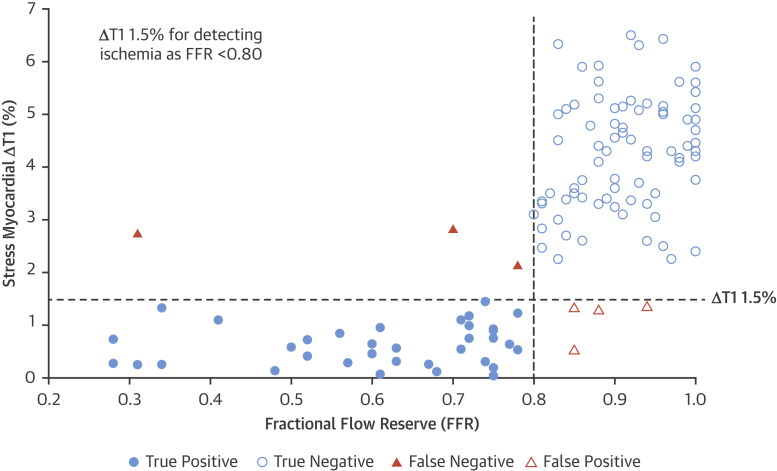
Relationship Between CMR Stress Myocardial ΔT1 and Invasive FFRA ΔT1 threshold of 1.5% optimally distinguished myocardial territories downstream of coronary arteries with FFR <0.8 and FFR ≥0.8 (data from 125 vessels in 60 patients). True positives: 38 vessels in 31 of 60 patients; true negatives: 80 vessels in 53 of 60 patients; false positives: 3 vessels in 3 of 60 patients; false negatives: 4 vessels in 4 of 60 patients. Abbreviations as in Figure 2.